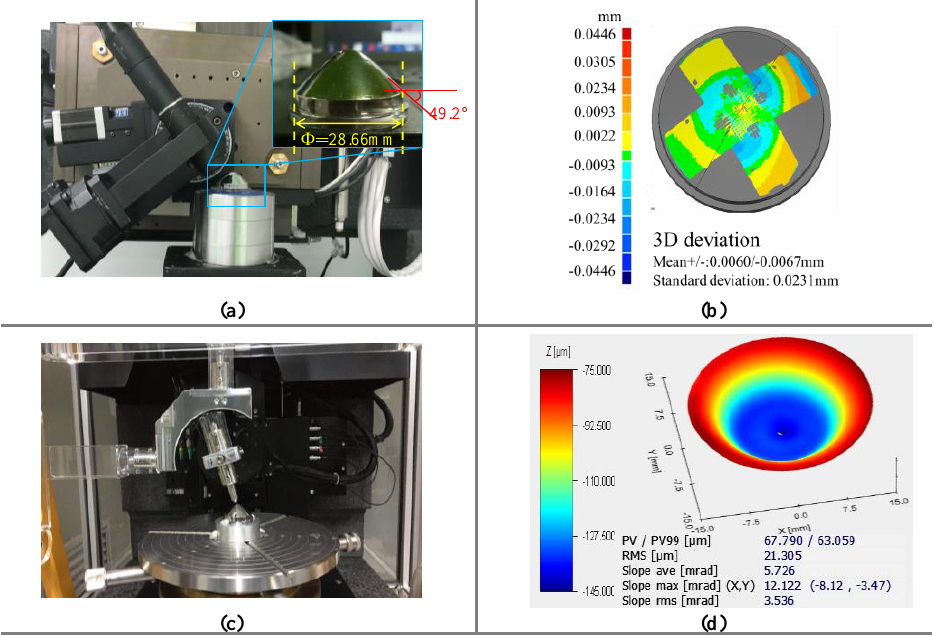
Table 6. The results of repeated measurement of the conical mirror.